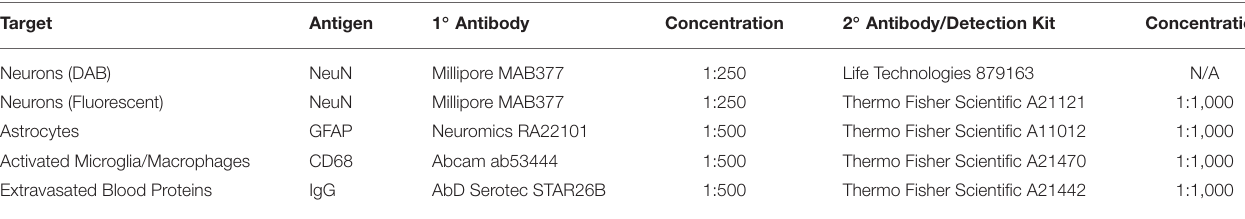
TABLE 1 | Summary of immunohistochemical reagents used in histology.